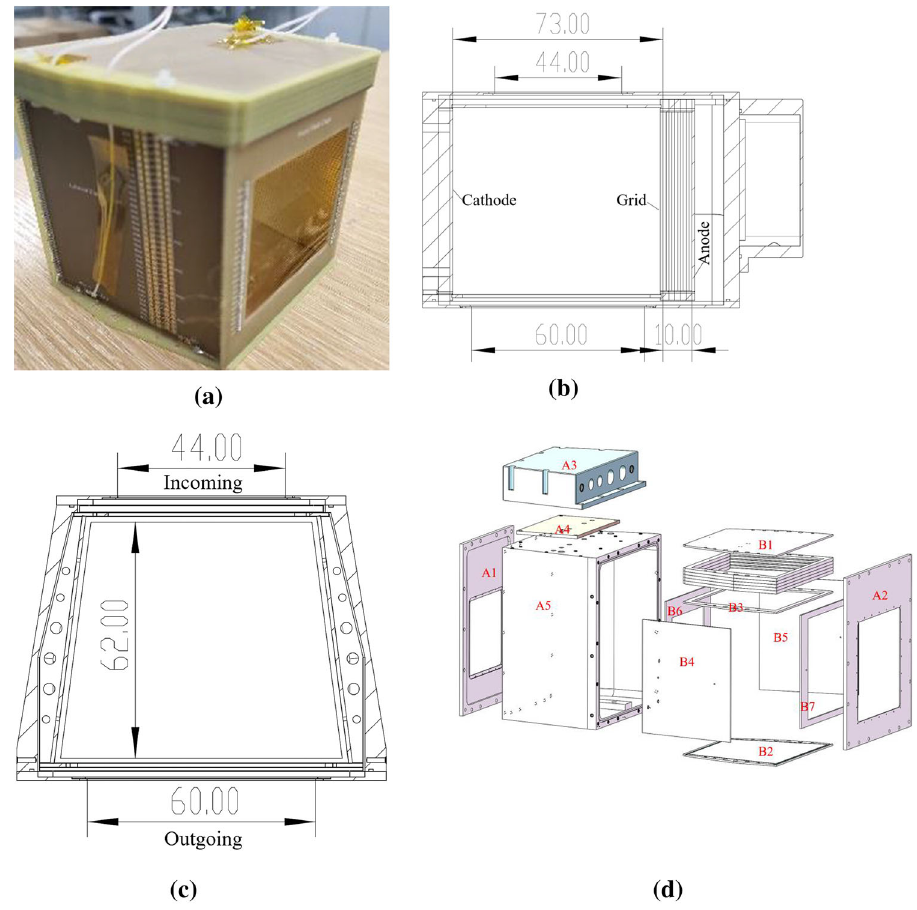
Fig. 2 Photographs and schematic diagram of the TFG-IC: main internal structure ( a ), cross section of side view ( b ), cross section of top view ( c ) and exploded structure diagram ( d ). A: Aluminum box; A1-incoming window, A2-outgoing window, A3-shielding box, A4-filter board, A5-shielding case. B: TFG-IC; B1-anode, B2-cathode, B3-grid, B4-cage of side plate, B5-cage of side plate, B6-cage of incoming window, B7-cage of outgoing